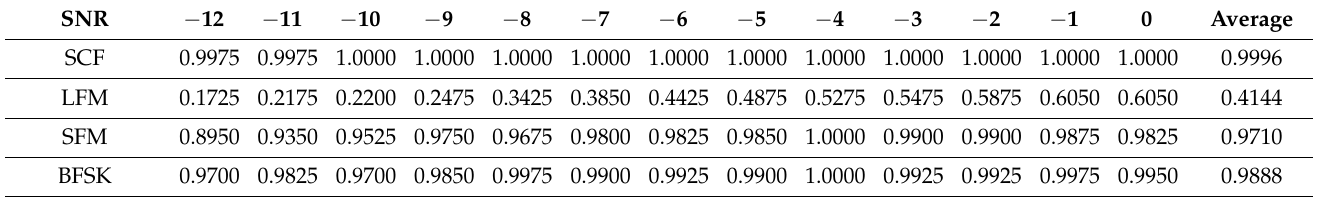
Table A12. Semi-supervised classification results with the datasets in Situation Dataset 4 without self-paced data augmentation ( T cycle = 26, NUM =